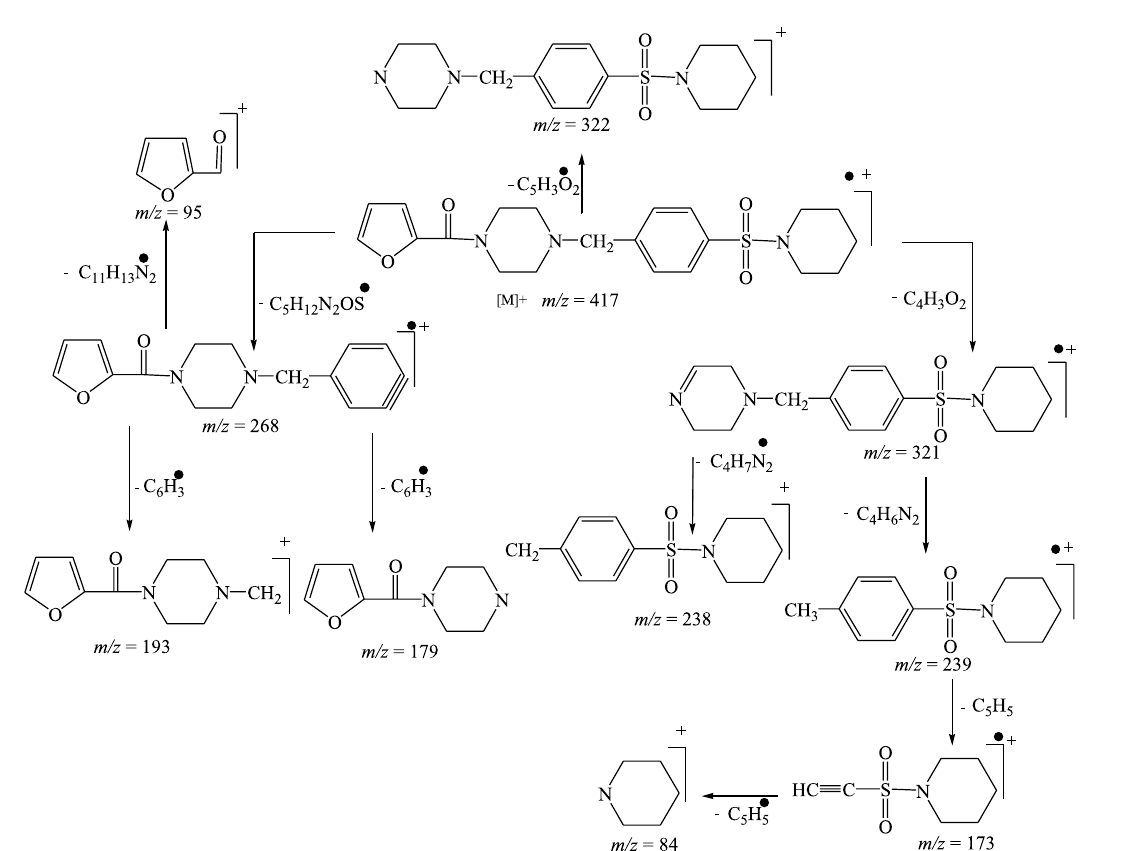
FIGURE 1 - Proposed mass fragmentation pattern of 2-furyl{4-[4-(1-piperidinylsulfonyl)benzyl]-1-piperazinyl}methanone ( 5c